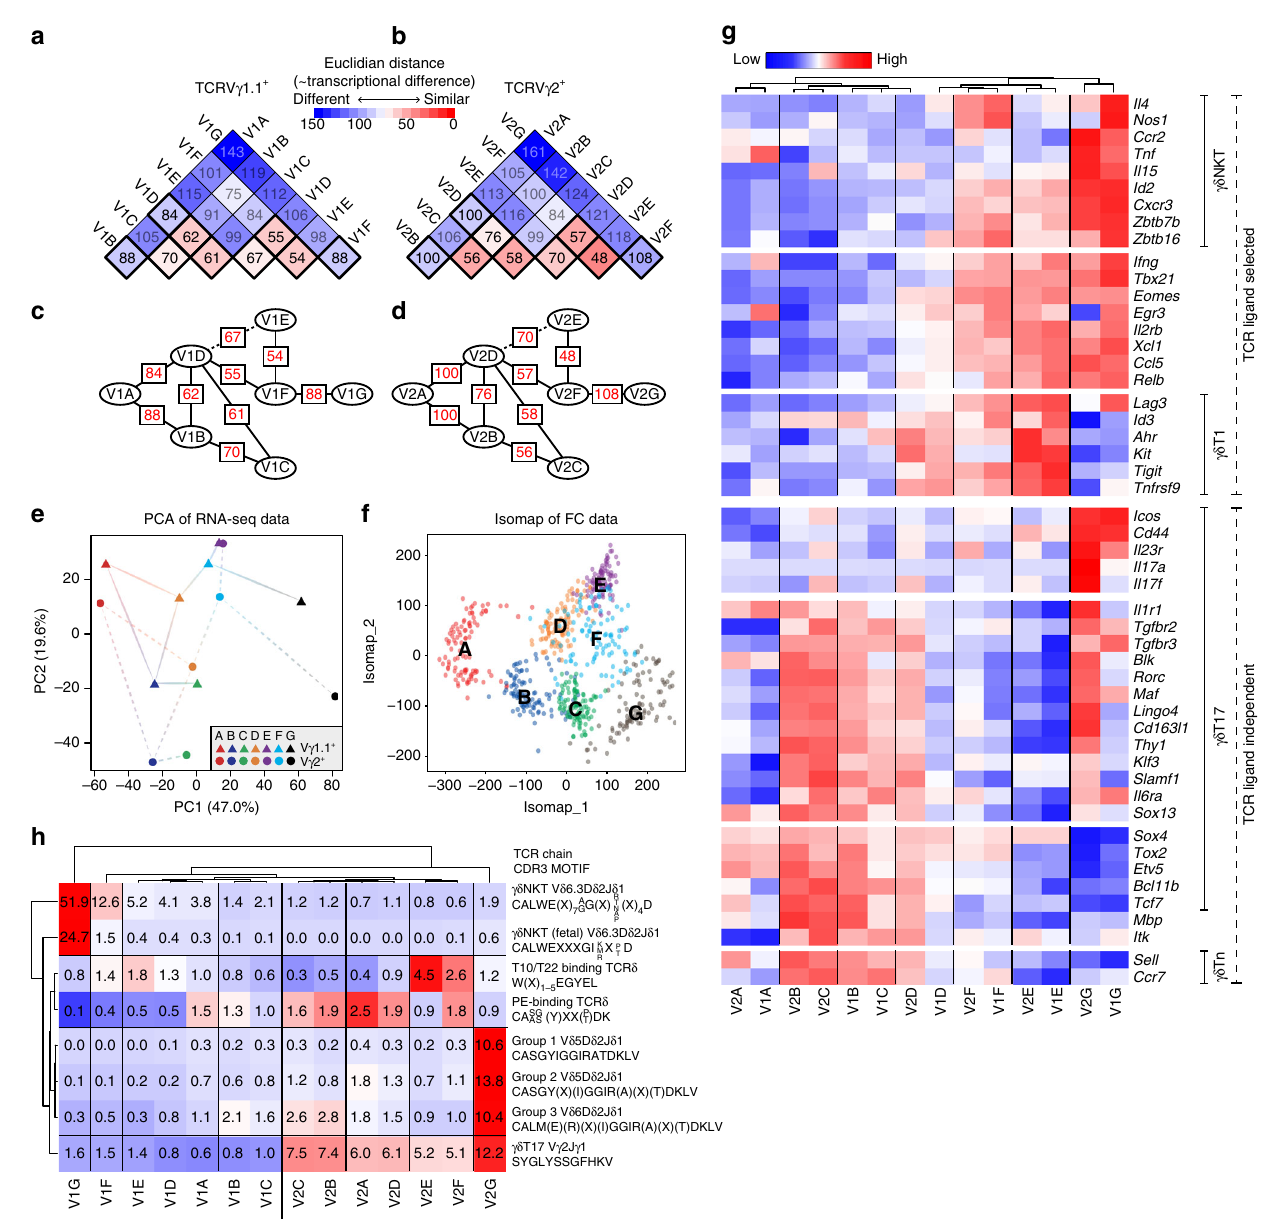
Fig. 3 Developing γδ T cells branch into populations with distinct effector characteristics a , b Pairwise Euclidian distances between each of the A to G populations calculated from whole transcriptome RNA-Seq expressions within a the V γ 1.1 + (V1A – V1G) and b the V γ 2 + (V2A – V2G) subset. Numbers and colours denote the mean Euclidian distances. c , d Diagrams of the shortest distances between the A to G populations, associating the most transcriptionally similar populations by lines within c the V γ 1.1 + and d the V γ 2 + subset. Red numbers denote the Euclidian distance between the two connected populations. e Principal component analysis (PCA) of RNA-Seq expression within the A to G populations of the V γ 1.1 + and V γ 2 + subsets. Lines correspond to the lowest pairwise distances shown in c , d . f Cellular progression predicted by fl ow cytometric expression of CD24, CD25, CD73, CD117, CD200 and CD371 by Isomap. Each A to G populations was reduced to 100 cells before analysis. Each dot represents a single cell. g Heat map showing expression of key transcription factors and effector molecules related to different γδ T cell effector subsets within the A to G populations of the V γ 1.1 + (V1A – V1G) and the V γ 2 + (V2A – V2G) subset. h Abundance of known TCR γ and TCR δ CDR3 motifs associated with different γδ effector subsets within the A to G populations of the V γ 1.1 + and the V γ 2 + subset. Numbers and colour depict the mean percentage of RNA-Seq reads including the indicated CDR3 motifs. Gene expression data are analysed as the mean expression from two independent RNA-Seq libraries, each constructed from RNA isolated from 24 mice across three independent cell sorting